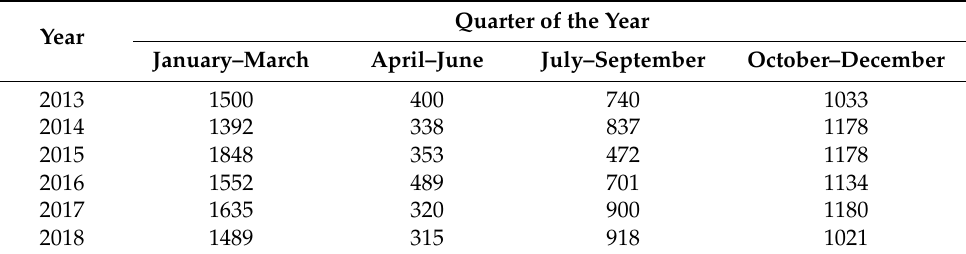
Table 5. Seasonal changes in the total salinity of water in the Ishim River within the Akmola Region between 2013–2018 (mg/L).